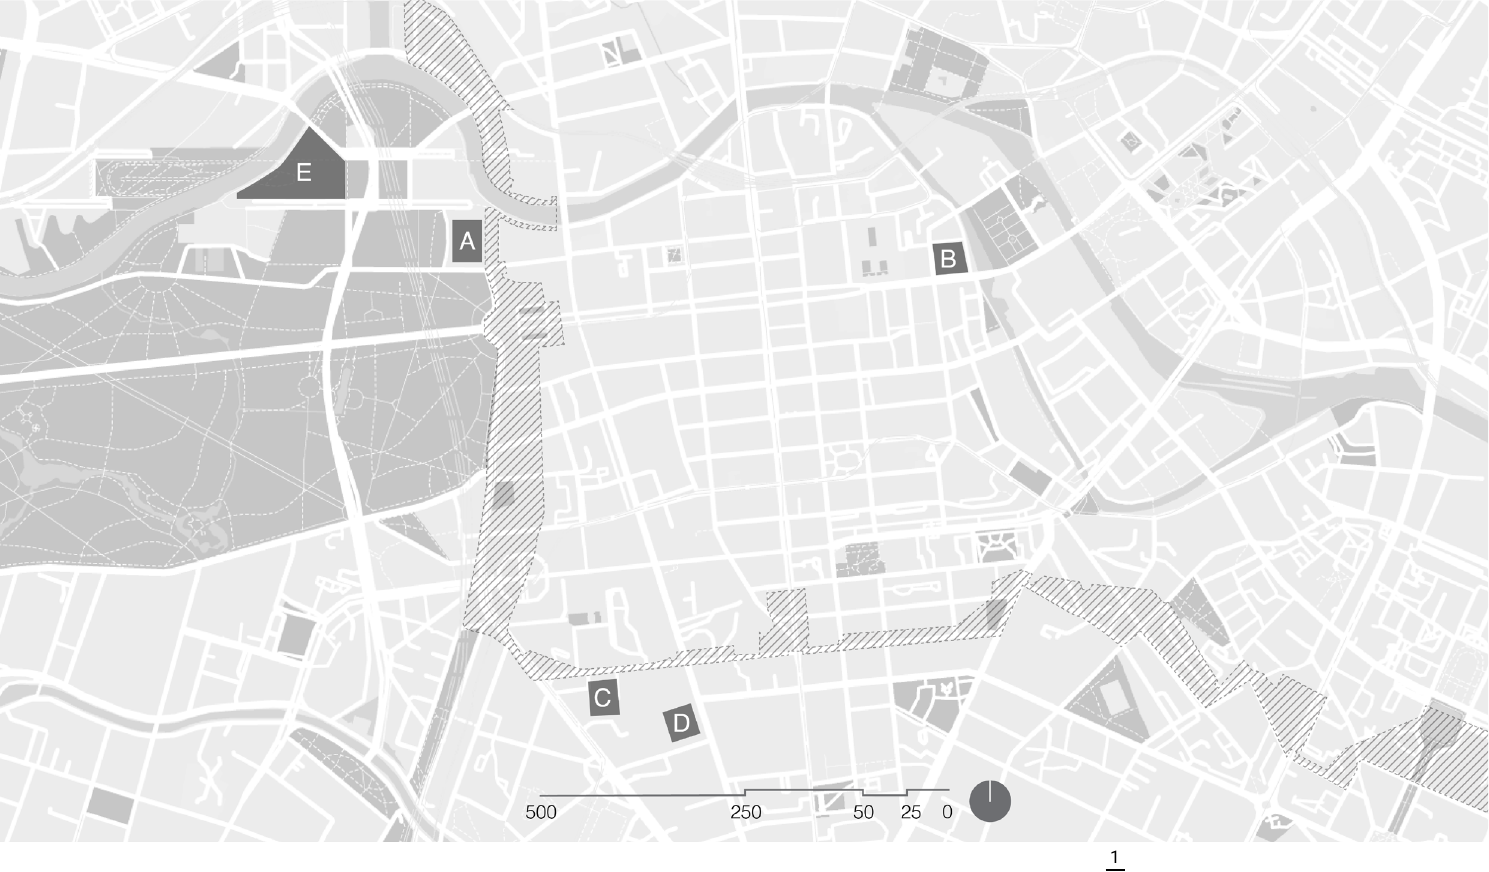
Fig. 1 Map of Berlin in its current state, showing (A) Reichstag building, (B) Zeughaus , (C) Martin-Gropius-Bau, (D) former Prinz-Albrecht-Palais, today the Topography of Terror documentation center, and (E) site for the DHM, now the Bundeskanzleramt . The former wall is shown